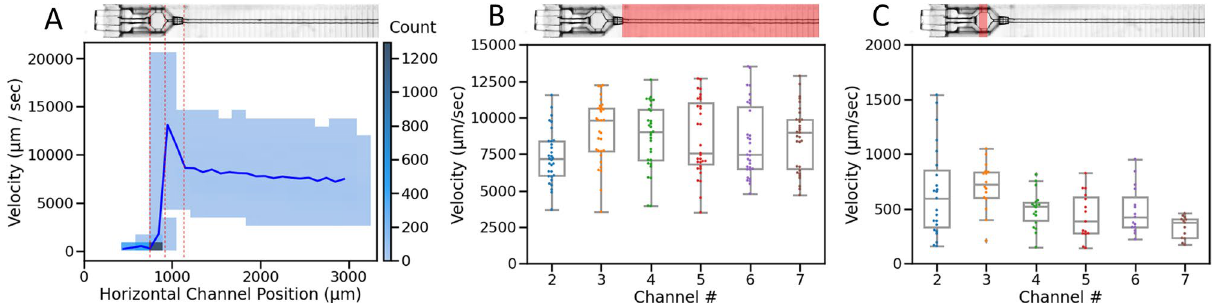
Figure 5. Bead velocity distributions captured at 4 × magnification in a single field of view for 6 channels (positions 2–7); ( A ) mean velocities combined from all channels overlaid on a 2D histogram of counts binned by velocity and position; with mean velocities per bead, per channel, calculated along the straight section ( B ) and within the cell chamber ( C 8465 ± 2253 μm/s, which corresponded to a flow rate of 1.00 ± 0.3 μL/min per channel. Uniformity of velocities between the channels was high for channels 3–7 (Fig. 5B; flow rates of 1.07, 1.03, 1.02, 0.99 and 1.01 μL/min respectively), with a reduction in particle velocities, and therefore calculated flow rate of 0.87 μL/min in channel 2. Channels 1 and 10 were unable to be assessed visually due to the nest’s titanium holder. However, from CFD results, flow in the outermost channels is expected to be further reduced. Inside the cell chamber, the particle velocities were significantly reduced, with a mean velocity for all channels measured as 523 ± 221 μm/s within the chamber centre (red highlighted area in Fig. 5C). The difference is flow velocity was lessened in the cradles compared to the channels since the volume of the former is much larger and thus any differences are greatly diminished. Particle velocity did not differ significantly within the cell chamber between the outer channel (2) and inner channels (5 and 6).